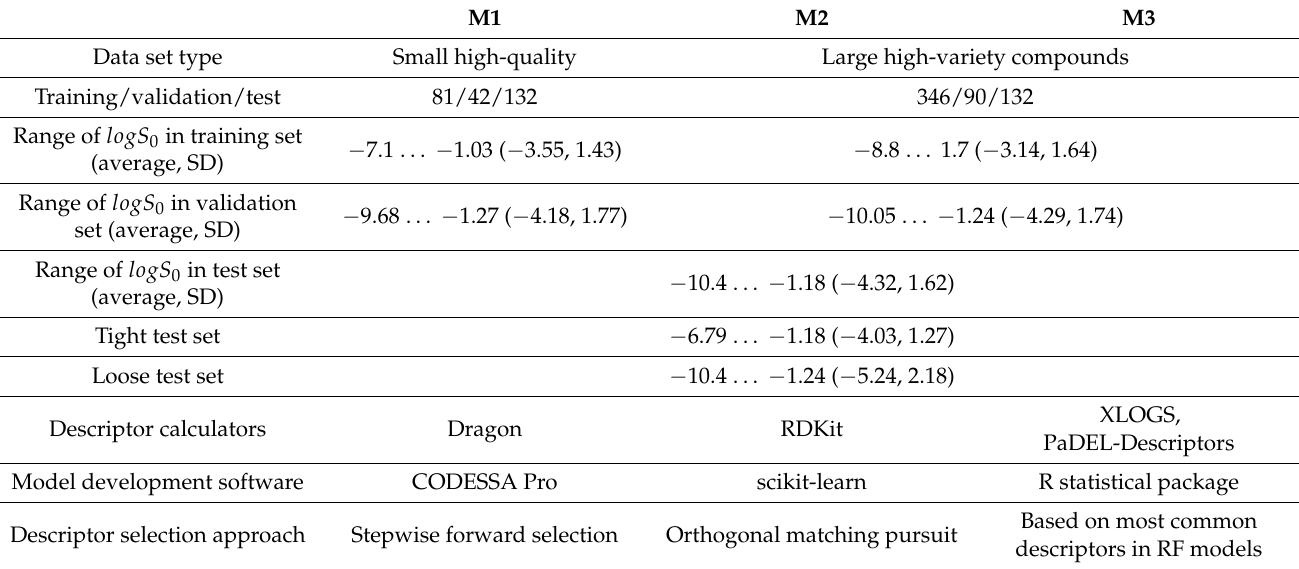
Table 1. Overview of the structure of the